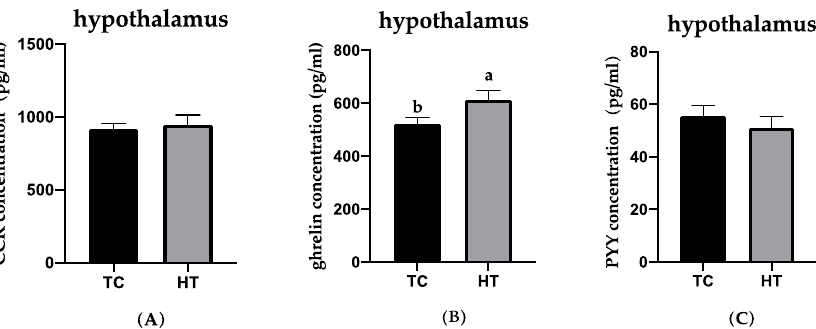
Figure 1. Effects of high temperatures on CCK, ghrelin, and PYY concentrations in the hypothalamus. ( A ), cholecystokinin; ( B ), ghrelin; ( C ), peptide YY. a,b, Means with different letters within columns indicates significant differences ( p < 0.05).